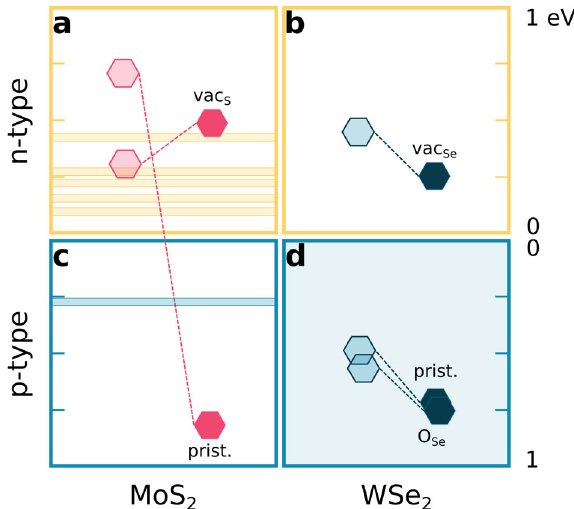
Fig. 4 Schematic illustrating the polarity of experimentally- measured TMDC/metal junctions. Data are shown for ( a , c ) MoS 2 / Au and ( b , d ) WSe 2 /Au interfaces. Yellow-shaded bands ( a , b ) indicate the approximate n -type Schottky barrier heights (SBH) extracted from experiments, while blue-shaded bands ( c , d ) indicate the approximate extracted p -type SBH. Note that the entire box in ( d ) is shaded blue since explicit SBH values were not listed in the experiments. Experimental values have been extracted from refs. 10,12 – 15,25 – 28 . Calculated QP (DFT) SBH values from this work are shown as fi lled (shaded) red (MoS 2 ) and blue (WSe 2 ) hexagons. “ prist. ” stands for “ pristine ”